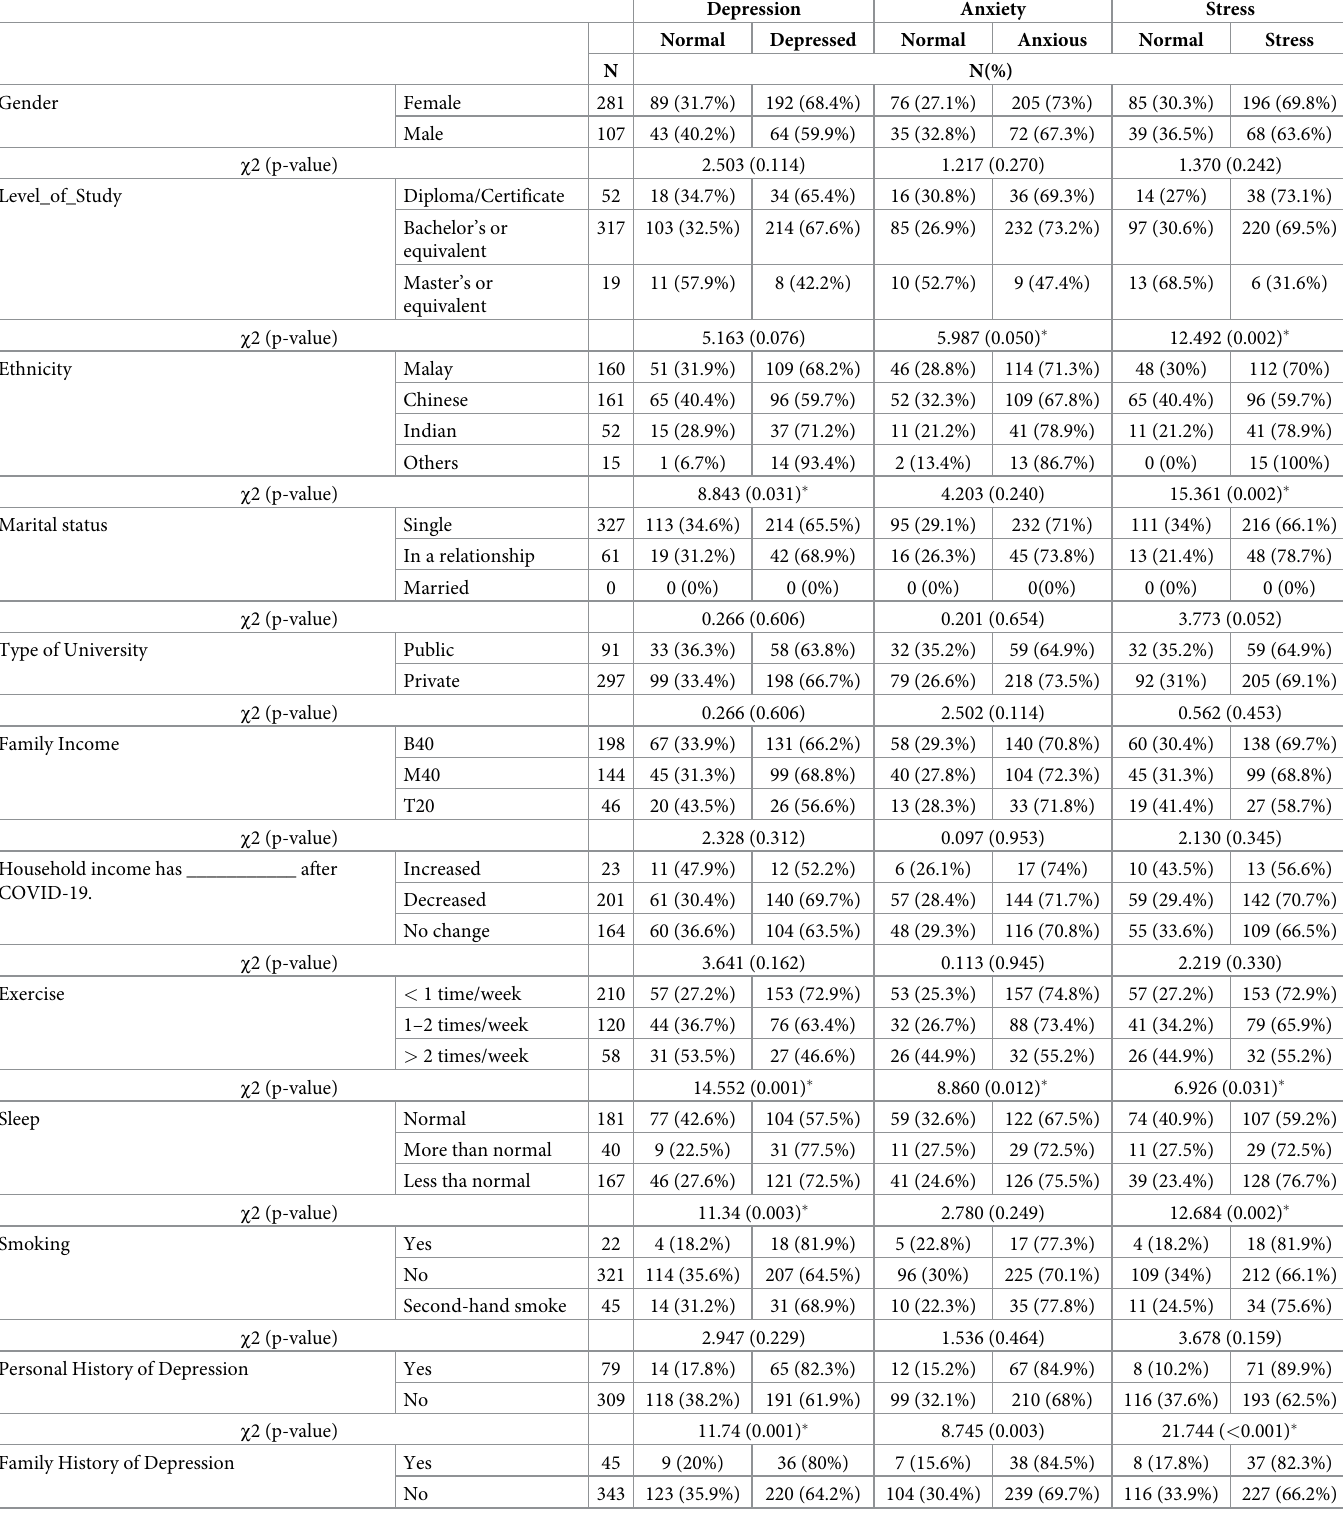
Table 2. Summary table of chi-square and mann-whitney U test